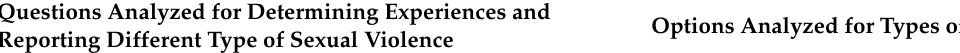
Table 5. Questions and Options analyzed from the